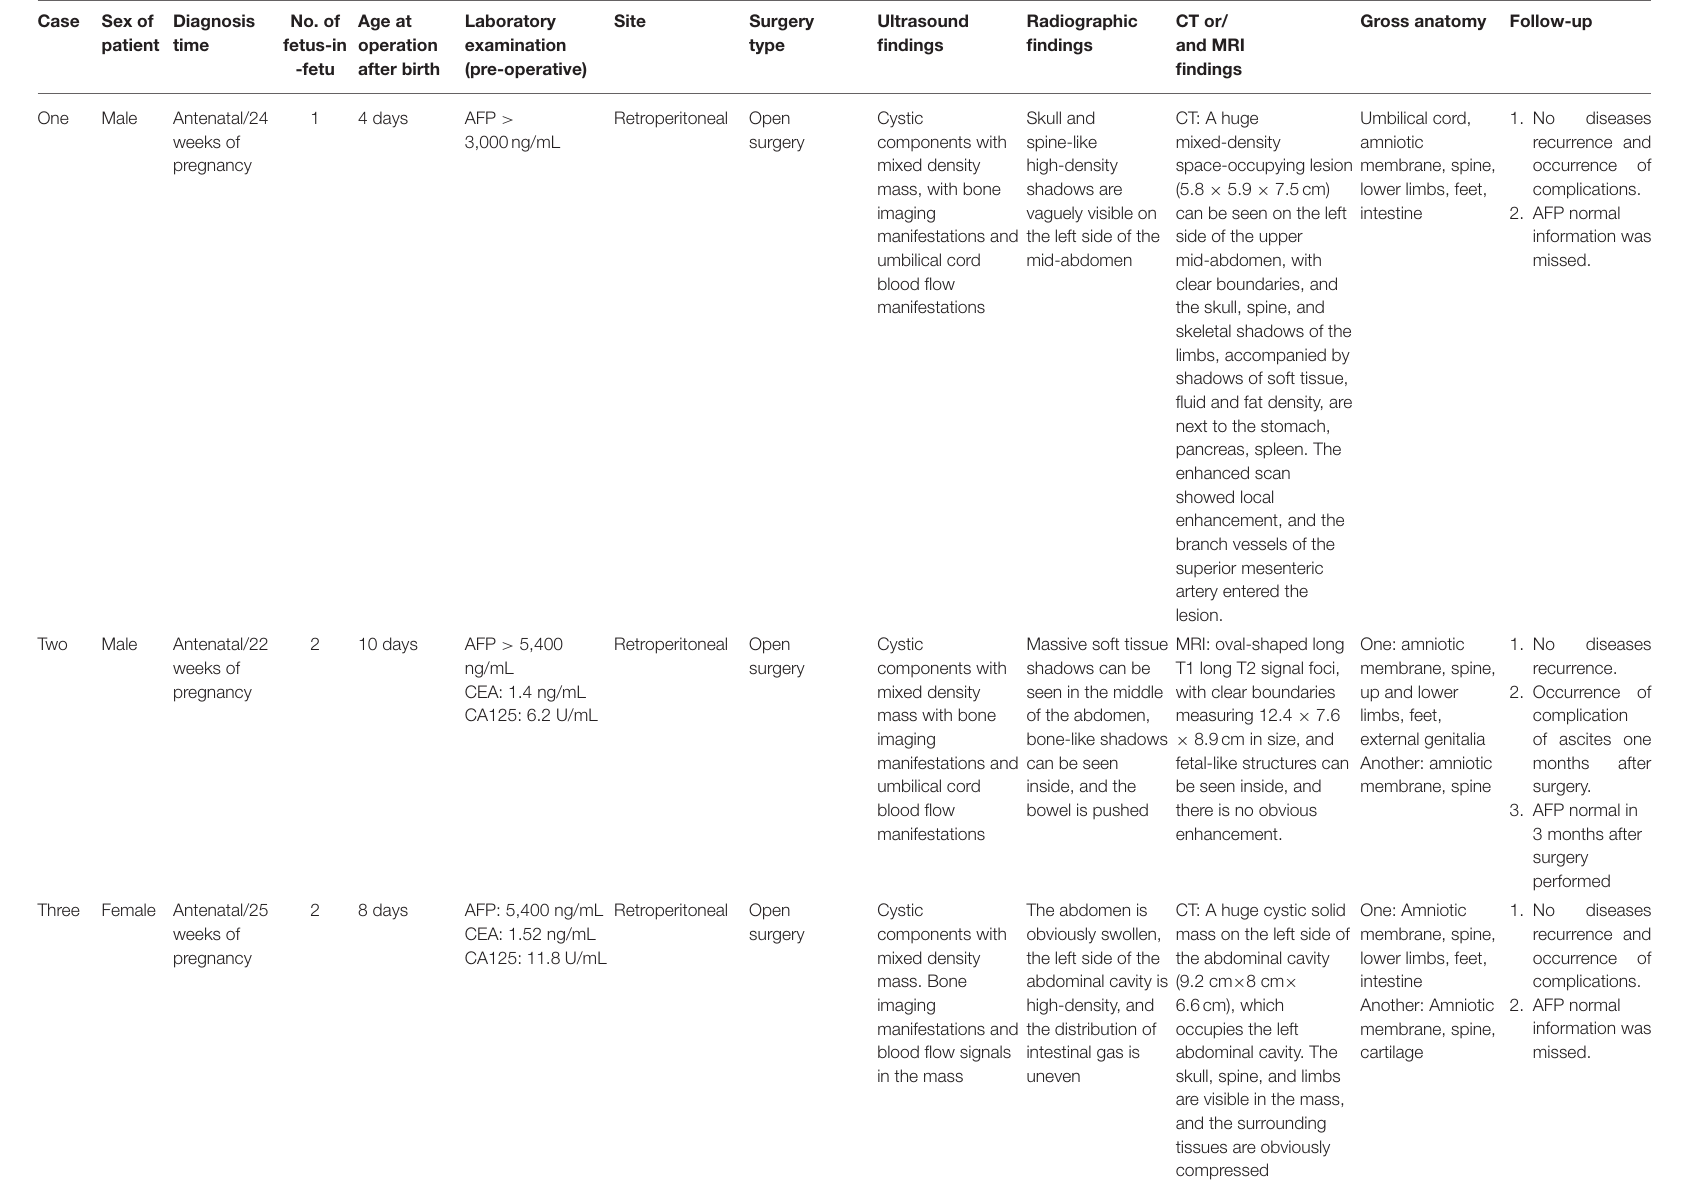
TABLE 1 | Summary of characteristics of all seven fetus-in-fetu